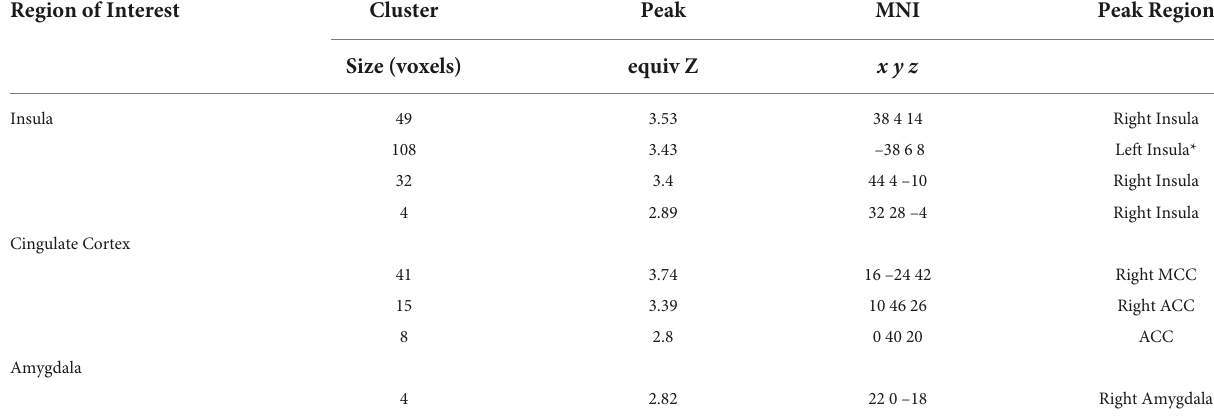
TABLE 2 Fear conditioning recall activation clusters.